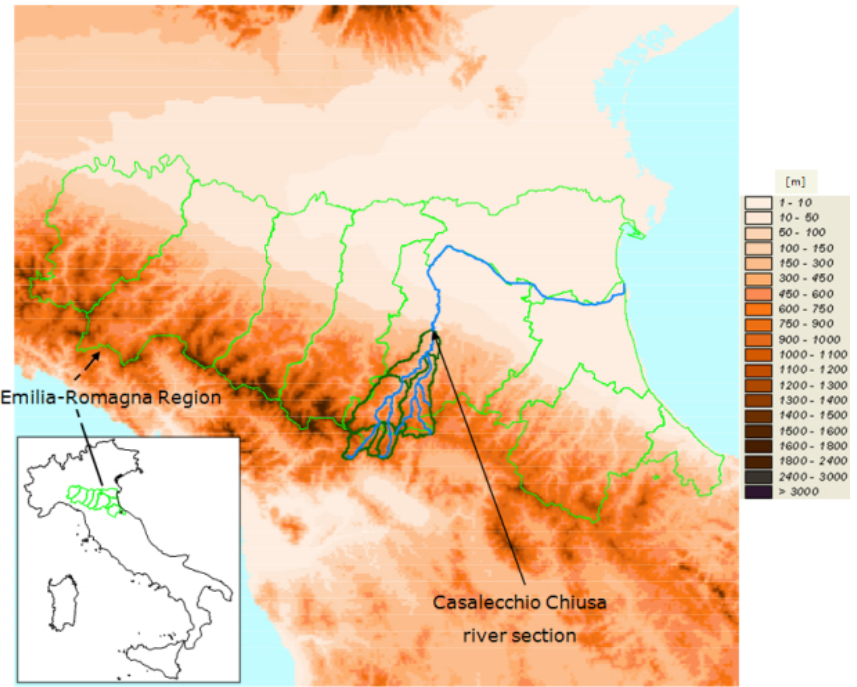
Figure 1. Localisation of the Reno river basin. The main river is showed in cyan. The upper part of the basin, closed at Casalecchio Chiusa, is evidenced with dark green